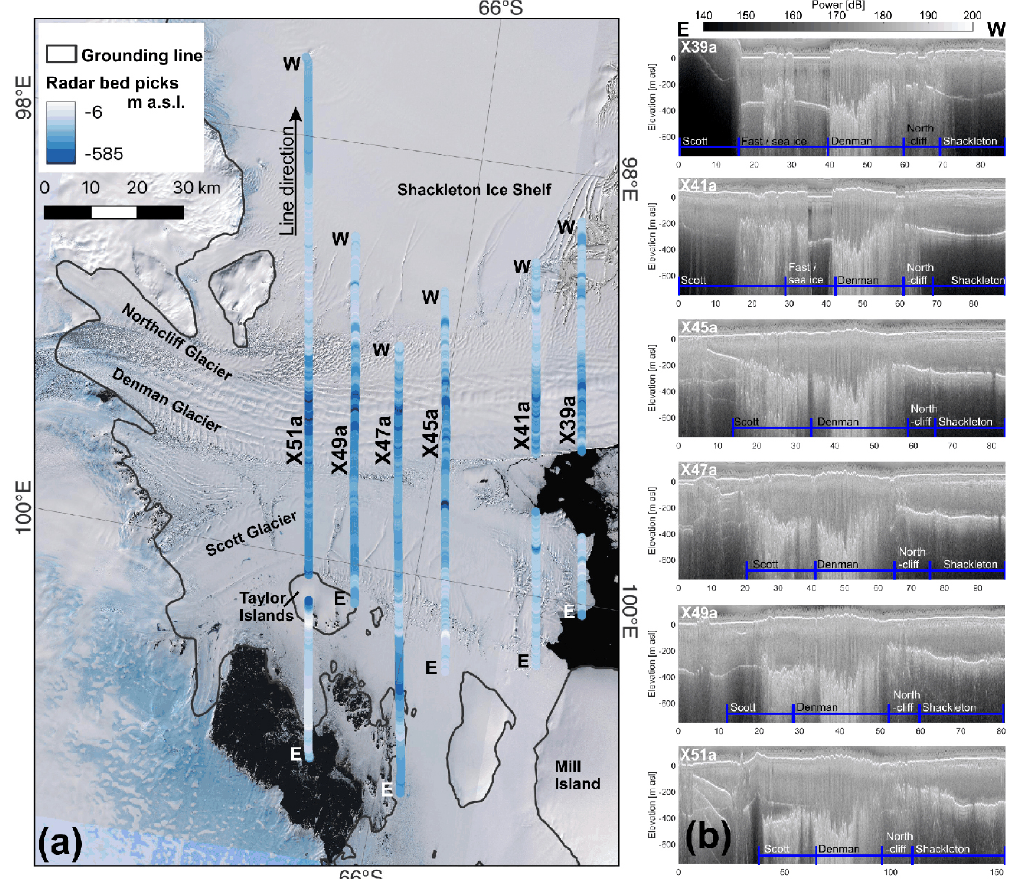
Figure 7. (a) The location and ice base below sea level of six ICECAP radar lines acquired in December 2016 (background Sentinel 2A acquired on 23 February and 1 March 2017). (b) Annotated ICECAP radar lines (position and east–west line direction shown in a